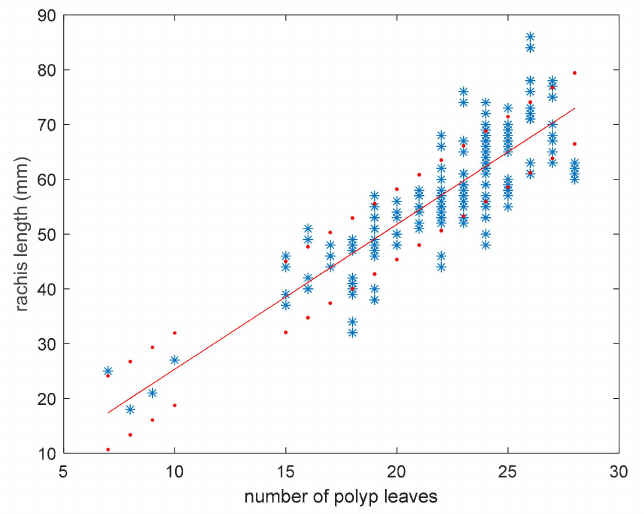
Figure 2. Rachis length vs. the number of polyp leaves in Pennatula rubra ; the red line is the linear regression, and red dot lines include 95% of